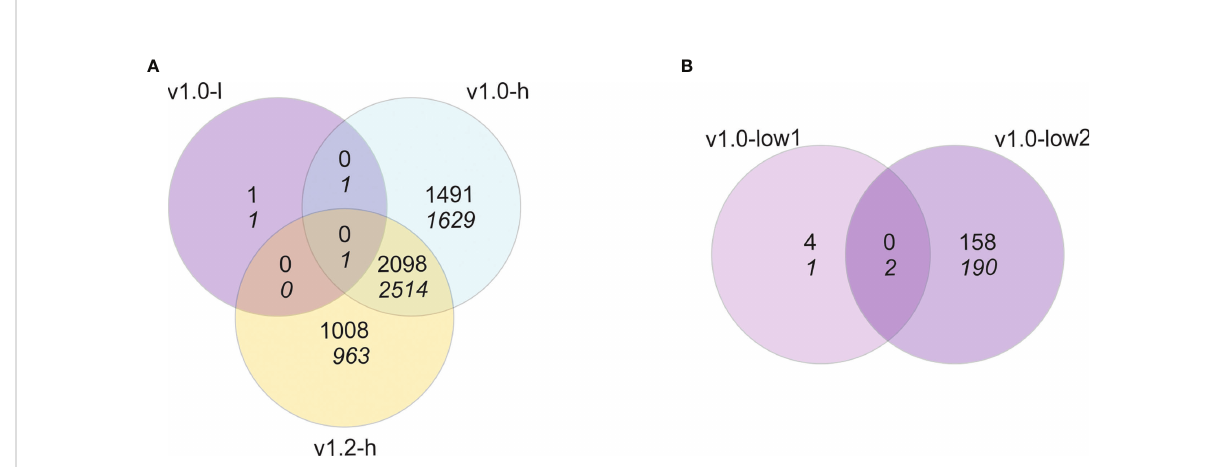
FIGURE 2 Transcriptional reprogramming is speci fi c for high-producing SxP. Venn diagrams of differentially expressed genes when contrasting (A) samples from pheromone producing plants (v1.0-l, v1.0-h, and v1.2-h with N = 8, 6, and 8, respectively) to wt N. benthamiana plants or (B) samples from the two individual lines of low pheromone-producing plants (v1.0-low1, v1.0-low2, both N = 4) to wt plants. Numbers on the top correspond to upregulated genes and numbers in italic on the bottom to downregulated genes (|logFC| > 1, pAdj <